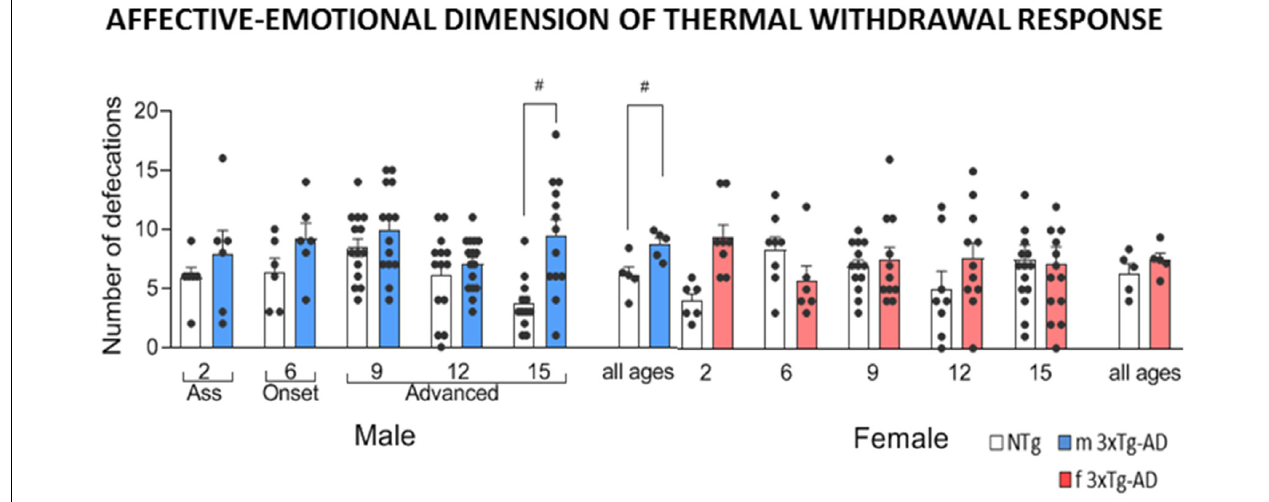
FIGURE 2 | Affective-emotional dimension associated with thermal withdrawal response in male and female 3xTg-AD and sex- and age-matched NTg mice with normal aging. Total number of defecations. Groups: NTg, non-transgenic mice (open bar); 3xTg-AD, transgenic mice (male “black,” female “red” bar). Error bars represent mean ± SEM. Statistics: Student t -test comparisons are shown in the graphs as # p < 0.01 vs. the NTg-group.